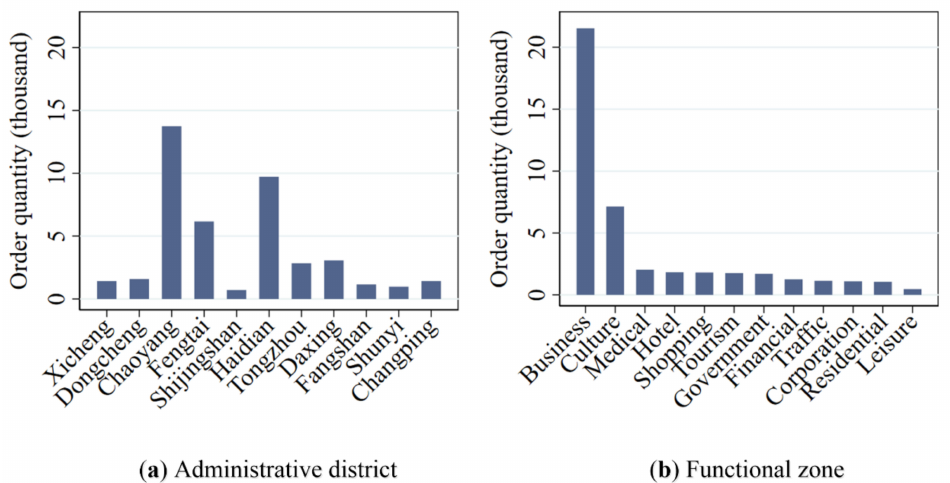
Figure 10. Quantitative distribution of car sharing orders in each administrative district ( a ) and functional zone ( b ). Notes: The administrative districts in Figure 10a are ranked in an ascending order by their distance from the city center.